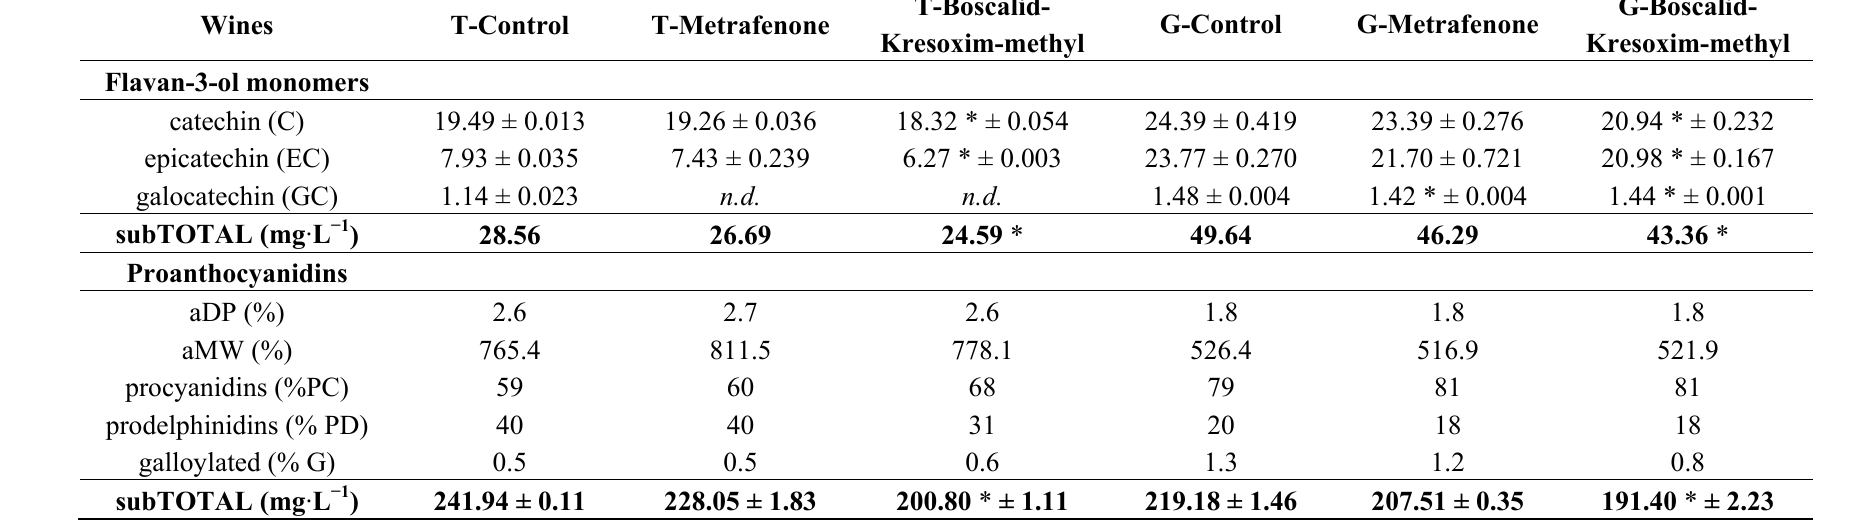
Table 2. Flavan-3-ol composition and quantitative data (mg·L − 1 ± SD) in Tempranillo and Graciano